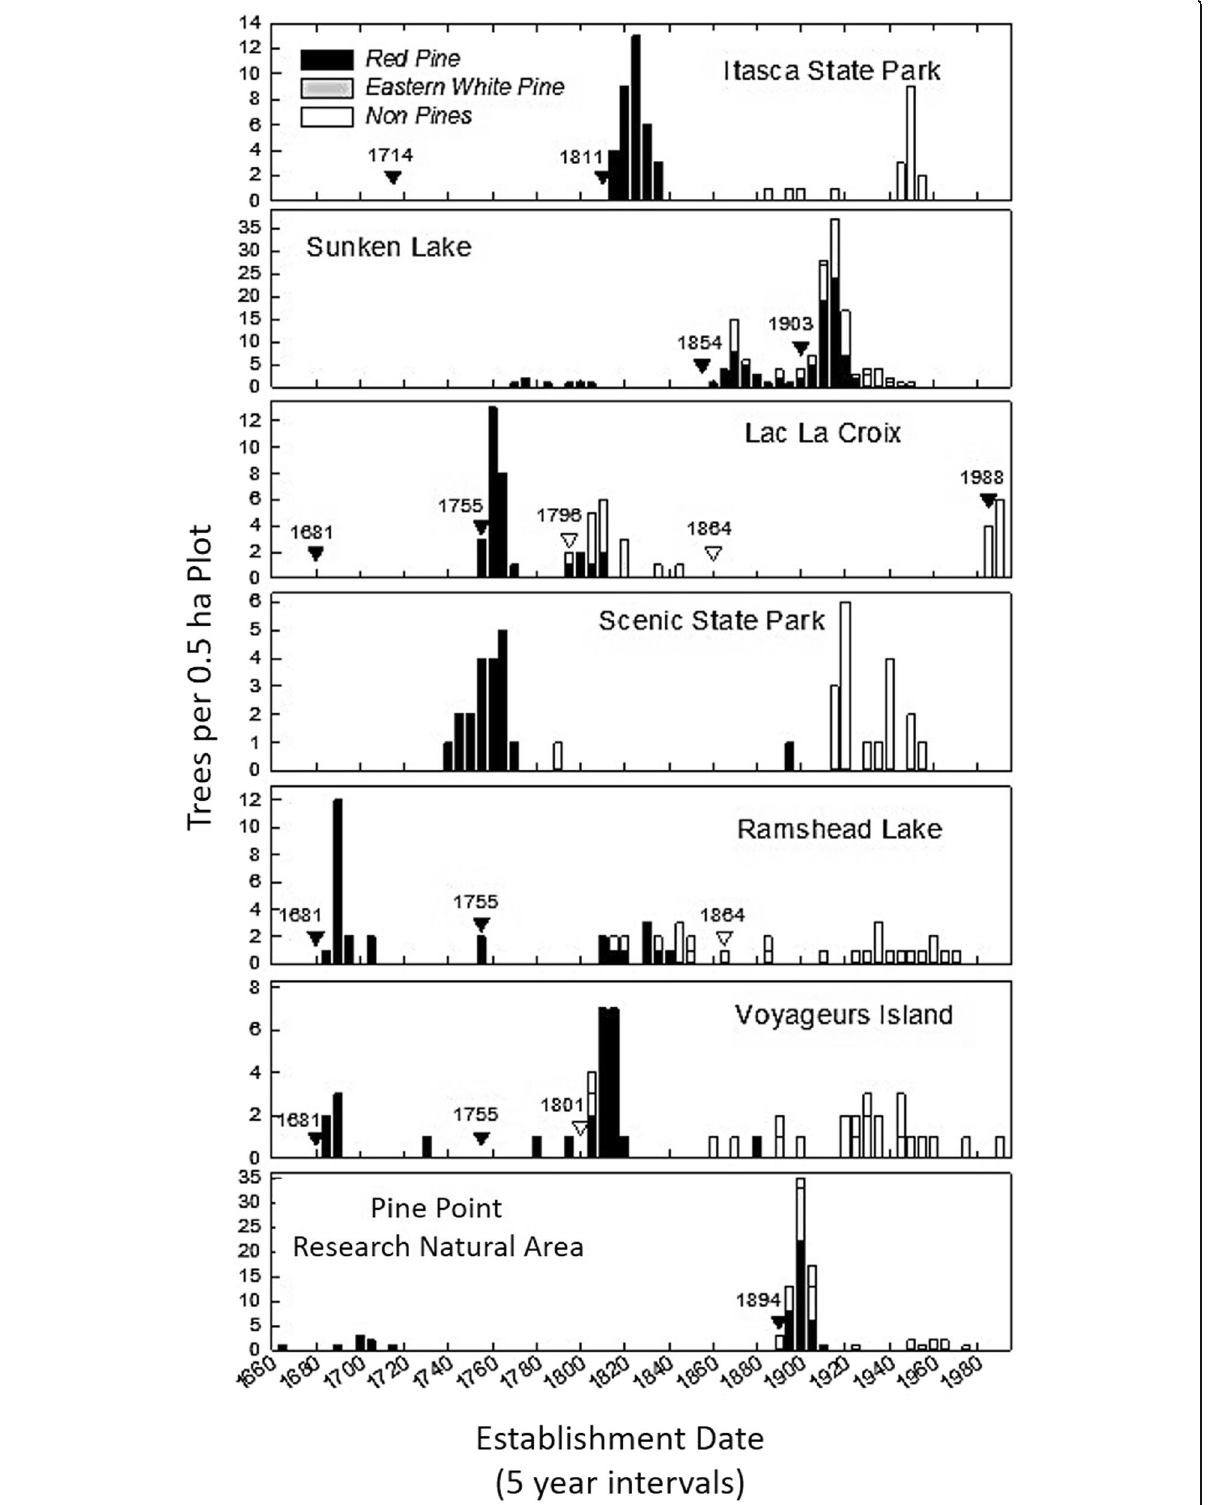
Fig. 2 Age structures for old-growth red pine-dominated stands in MN, USA, showing a variety of forms, including broadly single-cohort, two- cohort, and three-cohort structures. Dates are known fire occurrences. Solid triangles denote known fire dates in each stand; open triangles denote known fire dates from nearby stands. Redrawn from Fraver and Palik